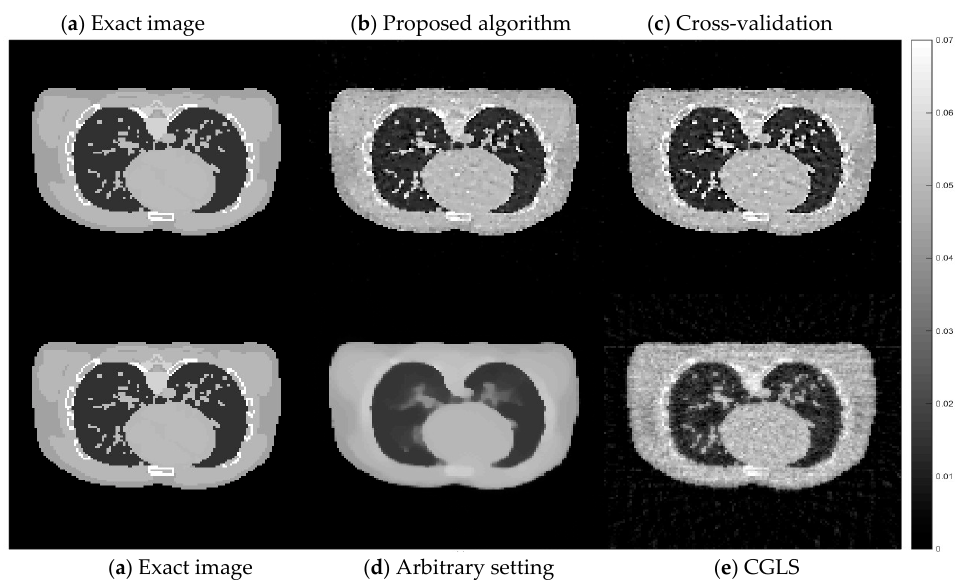
Figure 11. Cross-sectional slices of the reconstructed images from the male phantom using the same sets of hyperparameter settings and the CGLS algorithm as applied to the training dataset previously. The display window is [0–0.07].